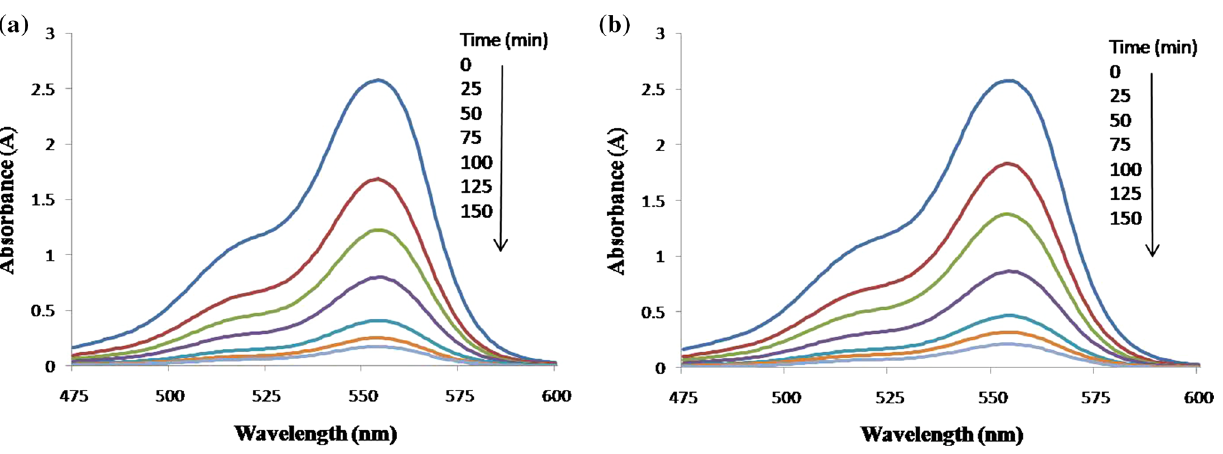
Fig. 4 UV–Vis spectra of RB dye before and after UV light irradiation photodegraded by a F-MWCNTs/Co–Ti oxide NPs and b Co–Ti oxide